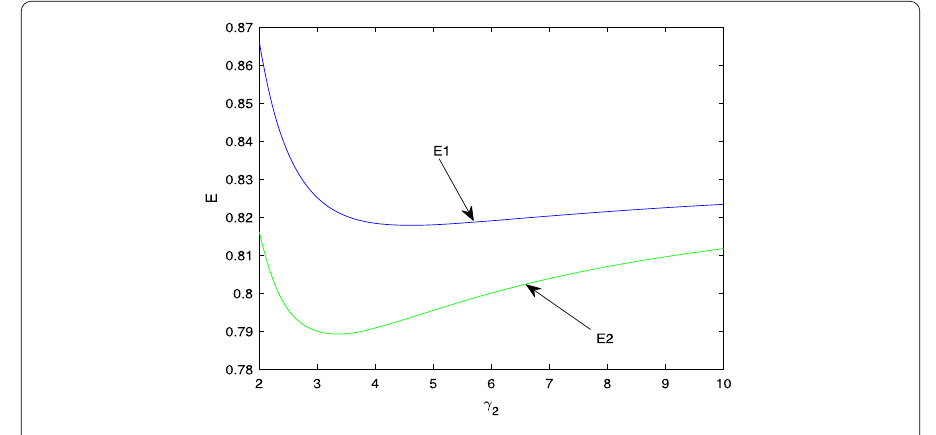
Figure 1 Error curves of E 1 and E 2 on the variable γ